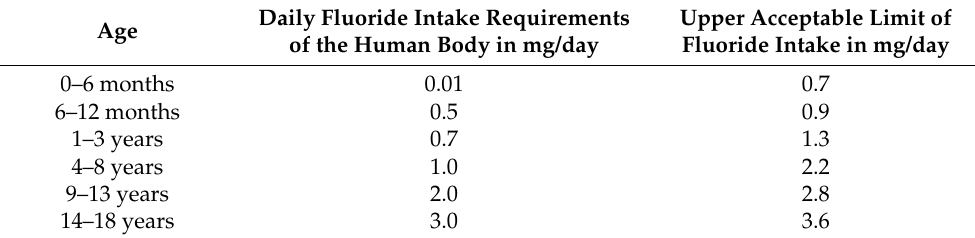
Upper Acceptable Limit